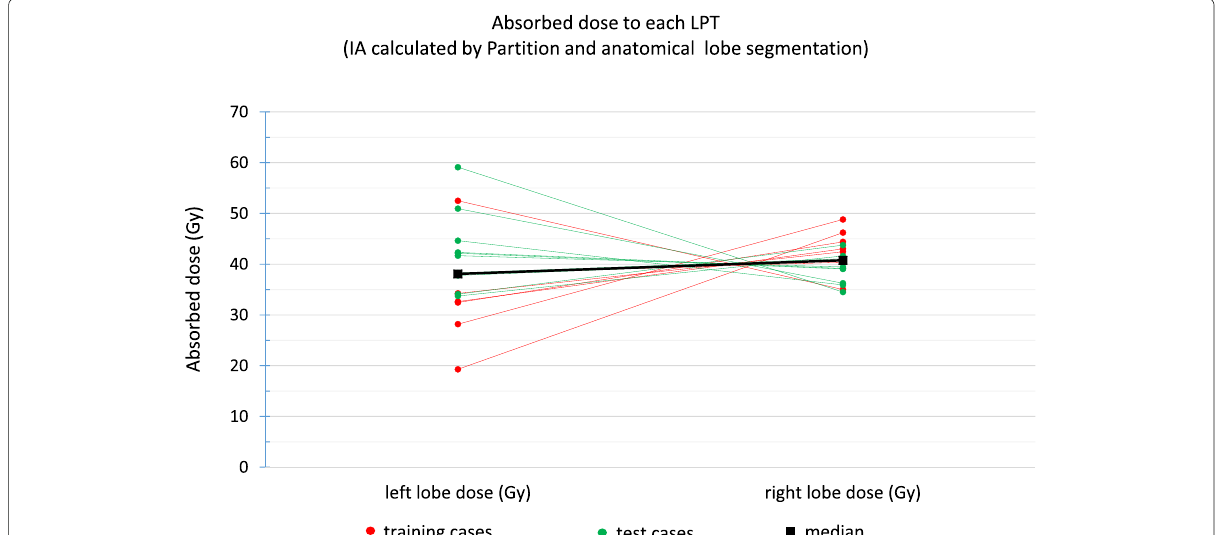
Fig. 14 Dosimetry simulation result in each lobe when we aimed at 40 Gy for each lobe based on standard venous anatomy delineation and using CBCT-based LPT segmentation and injected activity calculated by the partition method